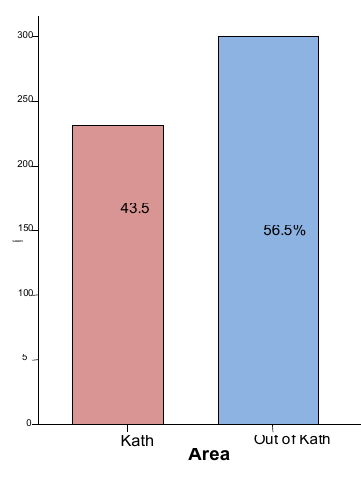
Figure 2: Distribution of cases according to geographical location